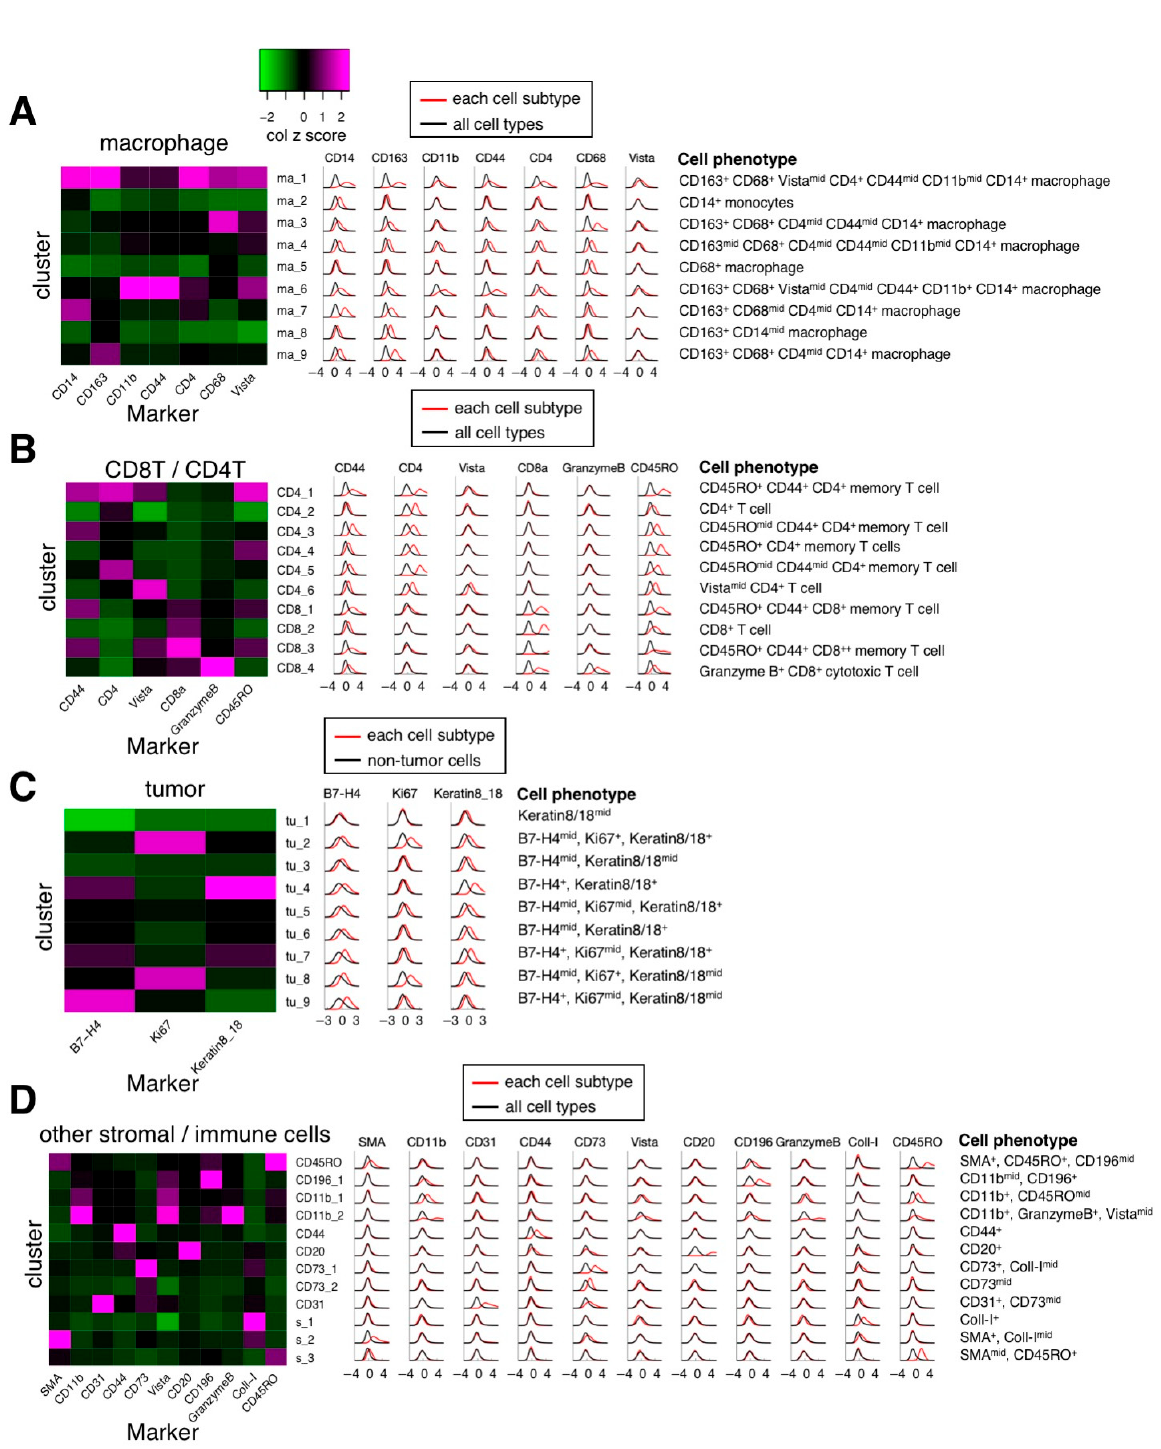
Figure 4. Marker expression levels of major individual cell subtypes. Left, heatmaps of median marker expression level (z-scored by column) for different major cell subtypes. Middle, histograms of Gaussian-smoothed ( σ = 0.5) normalized marker expression levels of the cells of each cell subtype across all samples (red line) and normalized marker expression levels of the cells of all cell subtypes across all samples (black line, ( A , B , D )) or normalized marker expression levels of the cells of non-tumor cells across all samples (black line, ( C )). Right, summary of phenotypes of IMC cell subtypes. ( A ) . Macrophage subtypes. ( B ). CD8 + /CD4 + T cell subtypes. ( C ). Tumor subtypes. ( D ). Other immune cell subtypes.